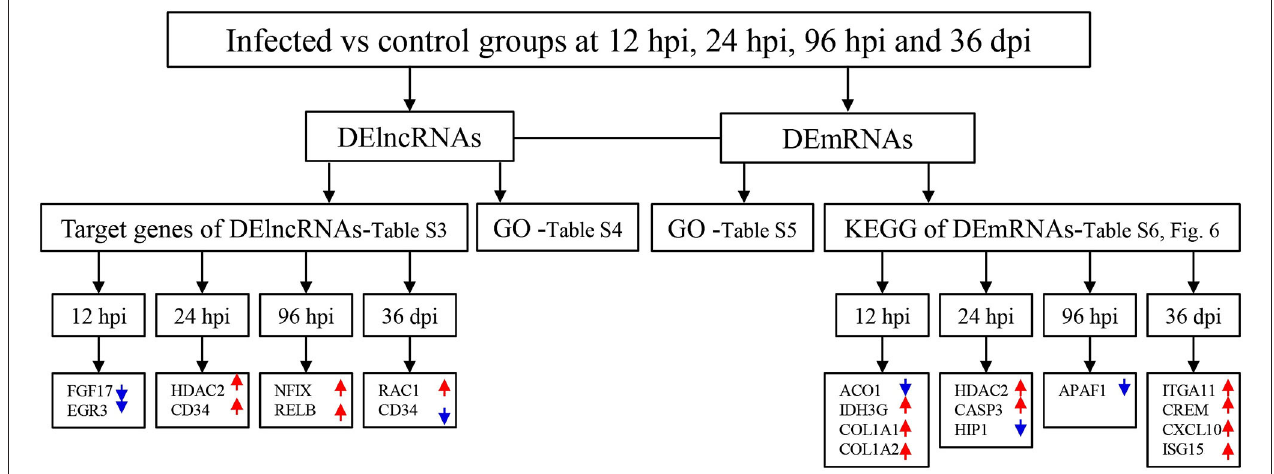
FIGURE 2 | The workflow of data processing. First, long non-coding RNAs (lncRNAs) and mRNAs were obtained by sequencing and the differentially expressed (DE) transcripts of lncRNAs and mRNAs were determined in the bone marrow of Beagle dogs at different stages of Toxocara canis infection. Then, Gene Ontology (GO) terms of the target genes of DElncRNAs, as well as GO terms and Kyoto Encyclopedia of Genes and Genomes (KEGG) pathway of DEmRNAs were determined. Increased and decreased expression of the transcripts are indicated by red upward pointing arrows and blue downward pointing arrows,